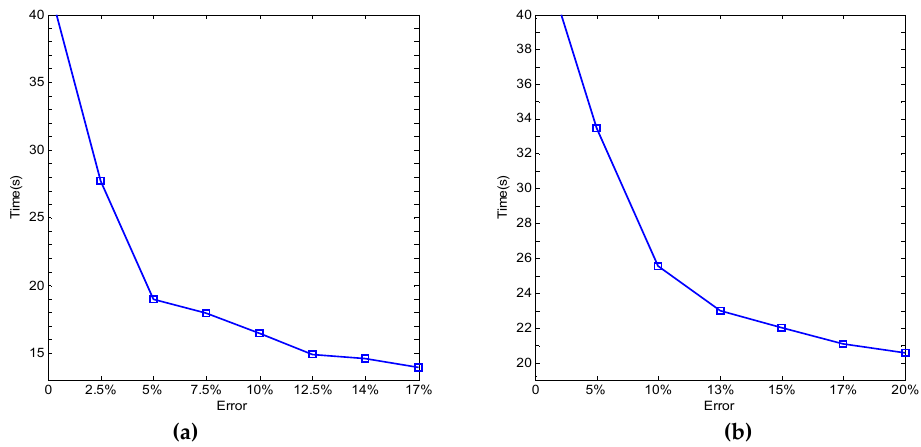
Figure 10. The relationship between forecasting error and forecasting time. ( a ) sunny day; ( b ) cloudy/rainy/snowy day.